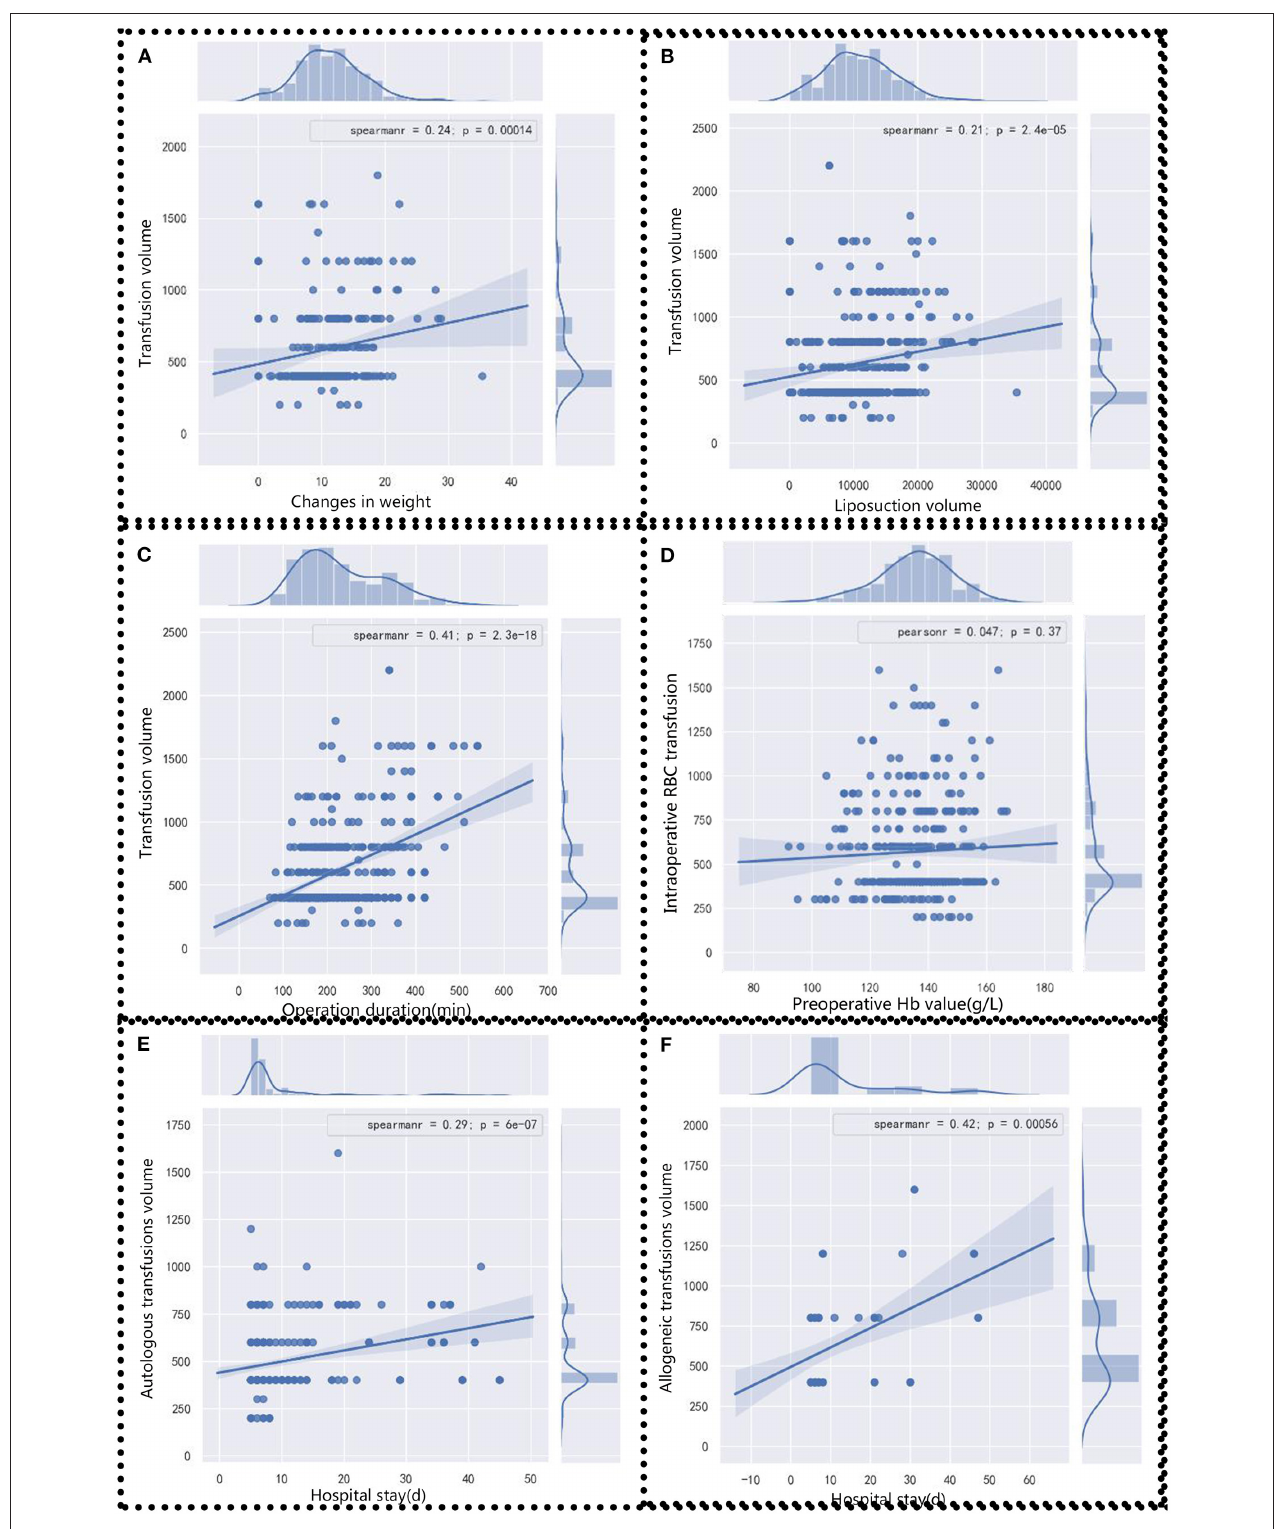
FIGURE 1 | Correlation analysis between clinical factors and blood transfusion volume. Blood transfusion volumes were analyzed with (A) body weight change, (B) liposuction volume, (C) operation duration, and (D) preoperative Hb value. (E) Autologous and (F) allogeneic transfusions volumes were analyzed with the length of stay. Pearson’s or Spearman’s analysis was chosen according to data distribution. Statistical significance was assigned at p < 0.05.